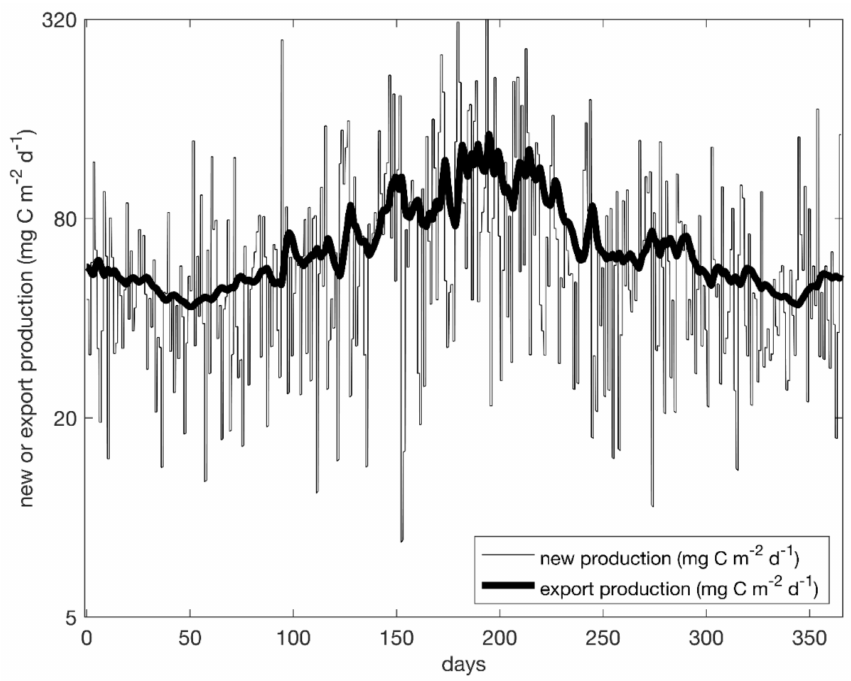
Figure 7. Daily new production and export production over the course of one year at a depth of 60 m at Station ALOHA. The expectation value of new production (NP) was assumed to vary in a sinusoidal manner with a period of one year based on data obtained from the Hawaii Ocean Time-series web site. Day-to-day variations of NP were assumed to follow a lognormal distribution with a coefficient of variation of 18% [2]. Export production was simulated by the food web